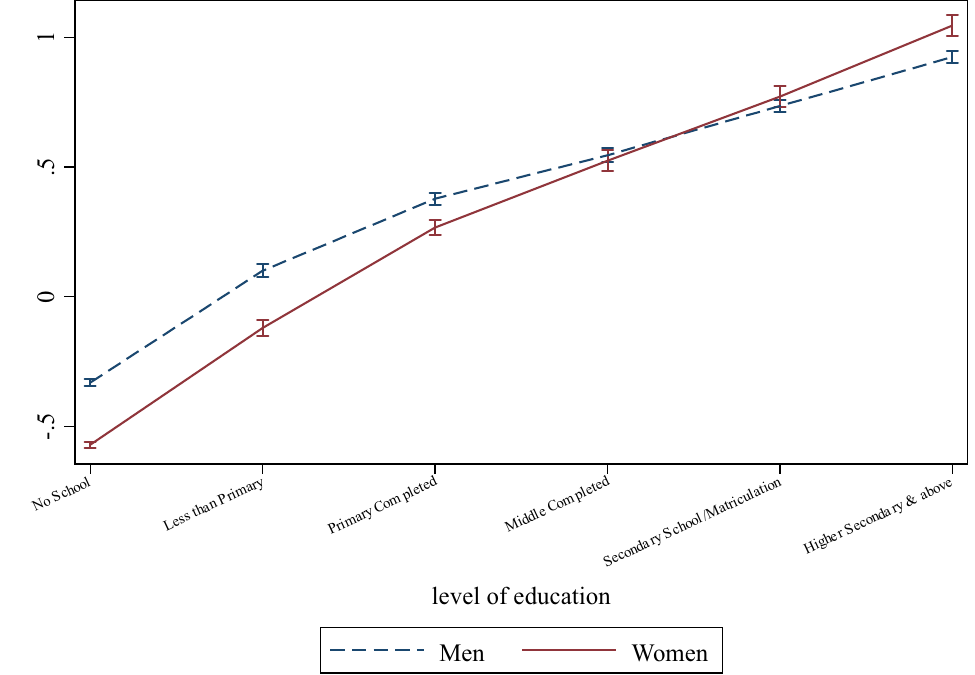
Figure 4. Predicted cognition scores by gender and education level. Predicted cognition scores with 95% confidence intervals are reported. Predictions are based on the estimates in the last column of Table S2. These estimates are adjusted for gender, age, caste, religion, rural/urban, region, father’s education, height, education level, and interaction terms between gender and education levels, and derived from a regression using survey